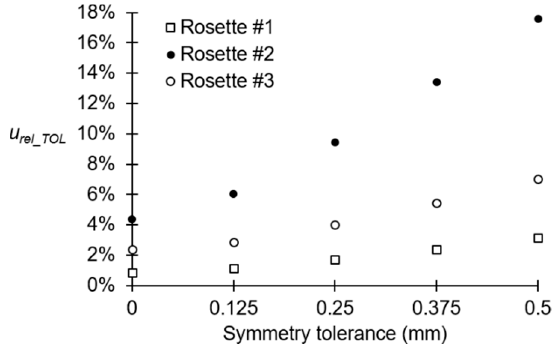
Figure 17. Evolution of the relative uncertainty of the Von Mises stress with respect to the symmetry tolerance.